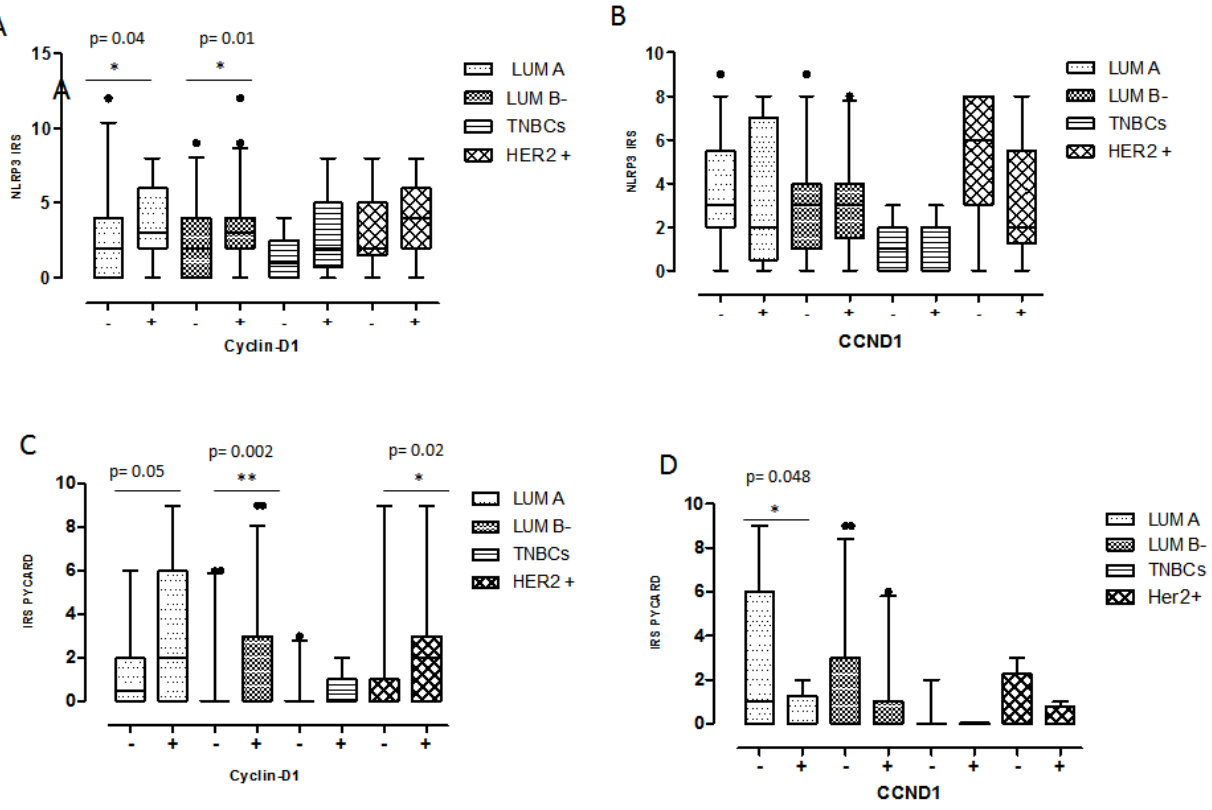
Figure 4. The distribution analysis of CyclinD1 and CCND1 negative and positive cases with respect to the inflammasome proteins in the different molecular groups. ( A ) NLRP3 expression in CyclinD1 positive and negative cases. ( B ) NLRP3 expression in CCND1 positive and negative cases. ( C ) PYCARD expression in CyclinD1 positive and negative cases. ( D ) NLRP3 expression in CCND1 positive and negative cases. IRS: Immuno Reactive Score. The IRS was calculated by the product of the Proportional Score (PS) obtained from the percentage of positive cells and the intensity of the staining (see the materials and methods section). Values are expressed as a median (horizontal bold line in each box), dot indicates outliers. * p < 0.05; ** p <